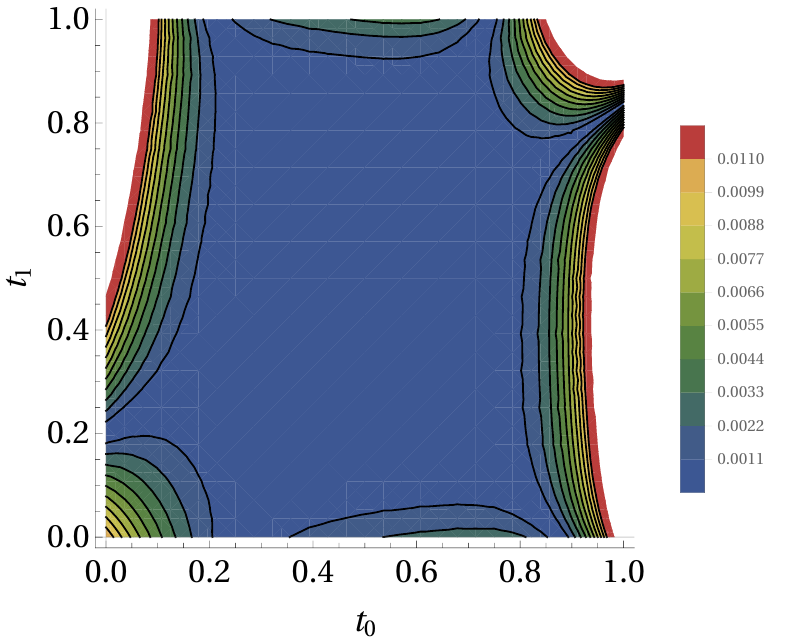
Figure 2 . A contour plot of the relative di(cid:11)erence between an ordinary sixth-order Taylor expansion and the actual integrand of S14 01220